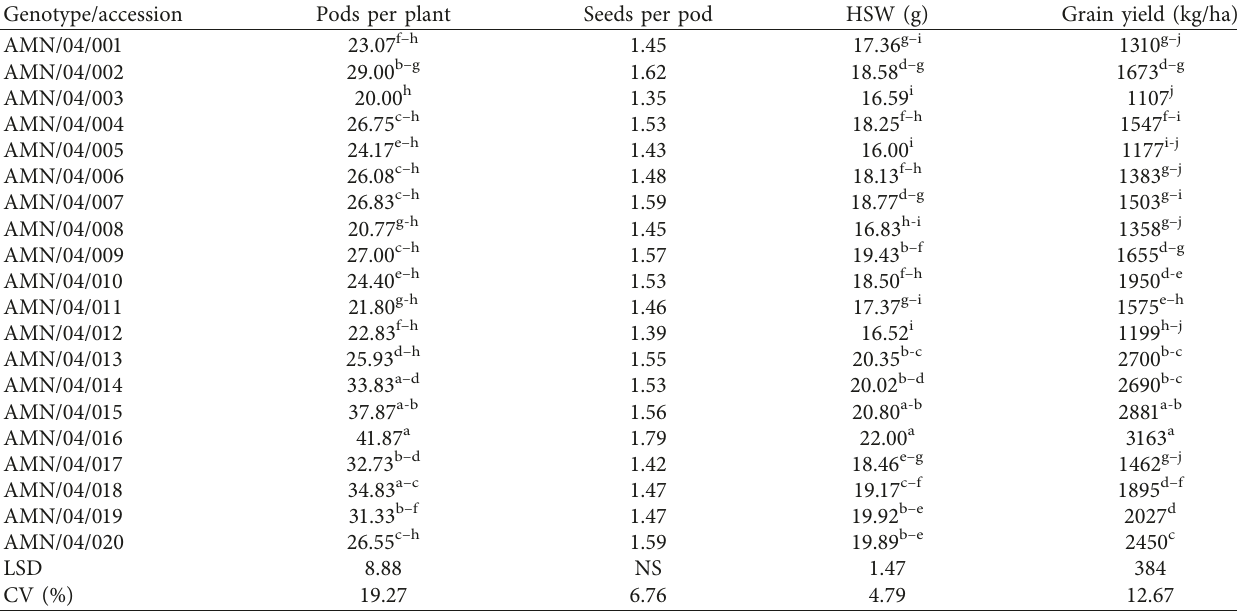
Table 4: Mean performance of genotypes of Bambara groundnut for yield components and yield.